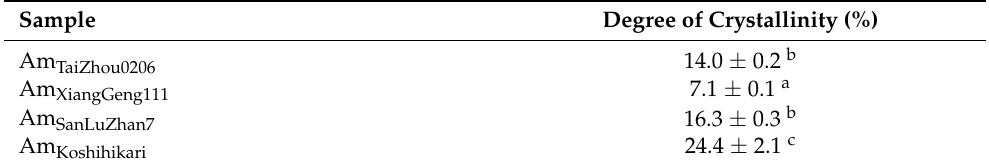
Figure 2. X-ray diffraction patterns for freeze dried amylose samples ( left figure ) and amylose samples with 10% moisture content ( right figure ). Table 2. The degree of crystallinity in amylose samples with 10% moisture content.